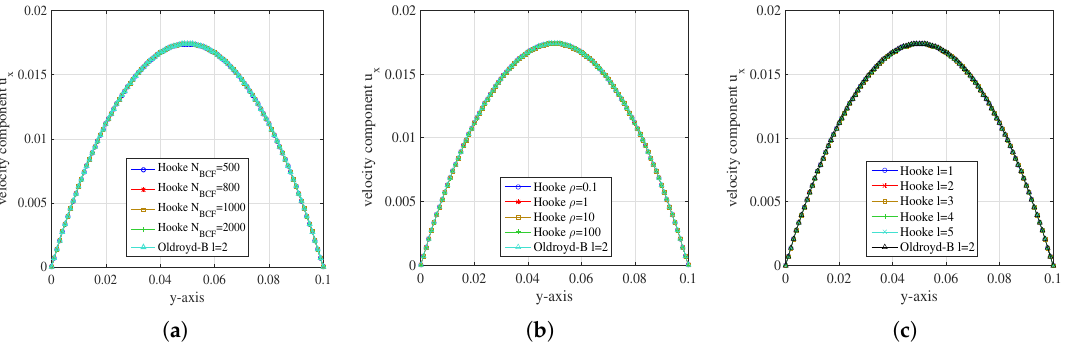
Figure 9. Velocity component u x on the vertical channel wall during the steady state at t = 1.999185: ( a ) for different N BCF of Hooke model and Oldroyd-B model l = 2; ( b ) for different Re number of Hooke model and Oldroyd-B model l = 2; and ( c ) for different mesh levels of Hooke model and Oldroyd-B model l =